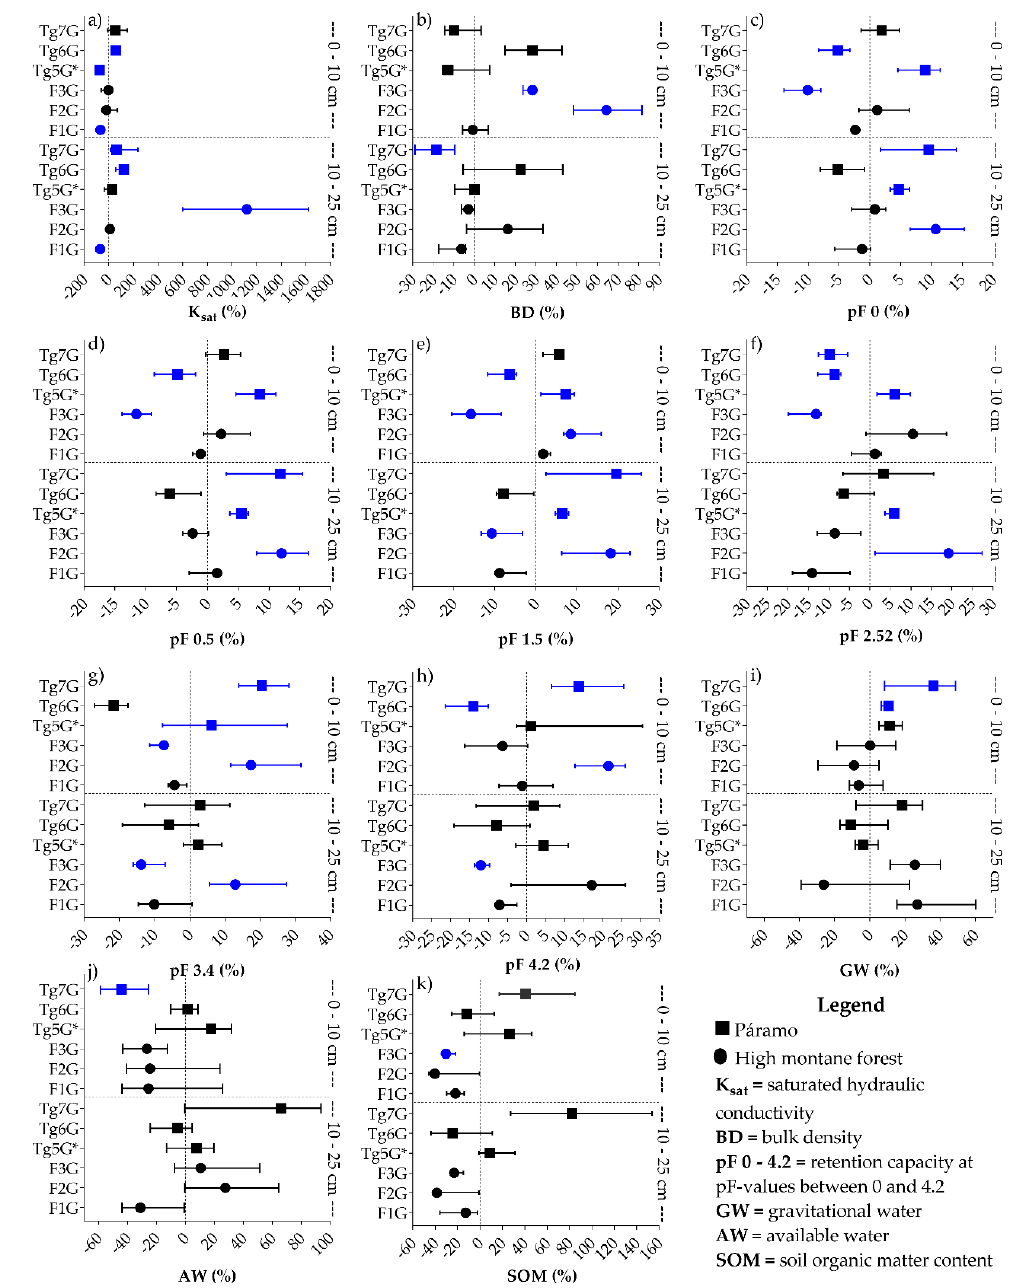
Figure 3. Forest and p á ramo plots showing the percentage change in the hydro-physical properties and SOM content (increase or decrease) of the soils’ surface horizons (0–10 and 10–25 cm) due to grazing. Site codes: FG = grazing in high montane forest; TgG = grazing in the p á ramo; TgG * = grazing in tussock grass subject to burning. Blue-colored lines represent a significant change ( p < 0.05) and black-colored lines represent a non-significant change ( p > 0.05) in the variable.